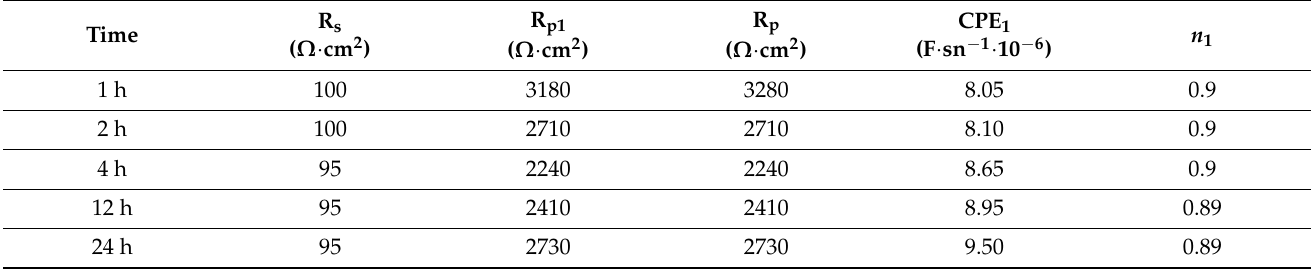
Figure 6. Electrochemical impedance behaviour of the as-cast AZ91 after different exposure times in 0.1 M NaCl solution, ( a ) Nyquist plots, ( b ) Bode plots. Table 3. Electrochemical characteristics of as-cast AZ91 in 0.1 M